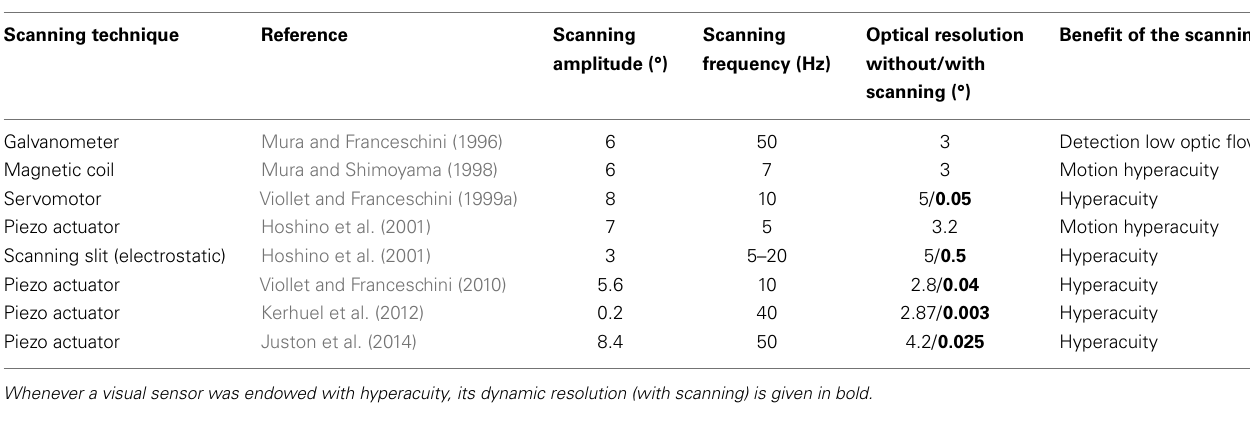
Table 1 | Summary of bio-inspired visual scanning sensors .